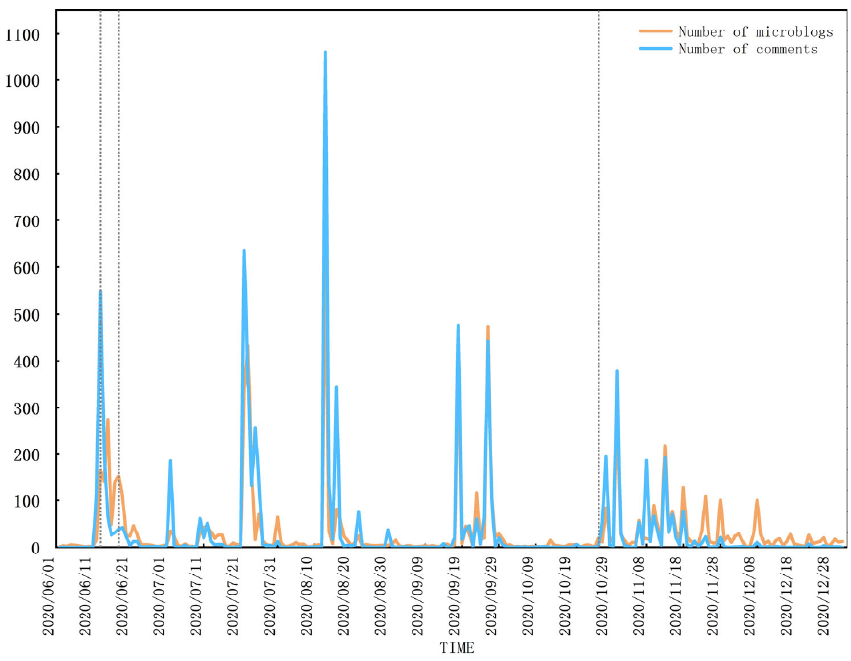
Figure 1. Life ‐ cycle stage of online public opinion on imported cold ‐ chain aquatic product safety. Figure 1. Life-cycle stage of online public opinion on imported cold-chain aquatic product To more accurately divide the public opinion event stages, the paper identifies the most influential microblogs on Sina Weibo based on the heat value.